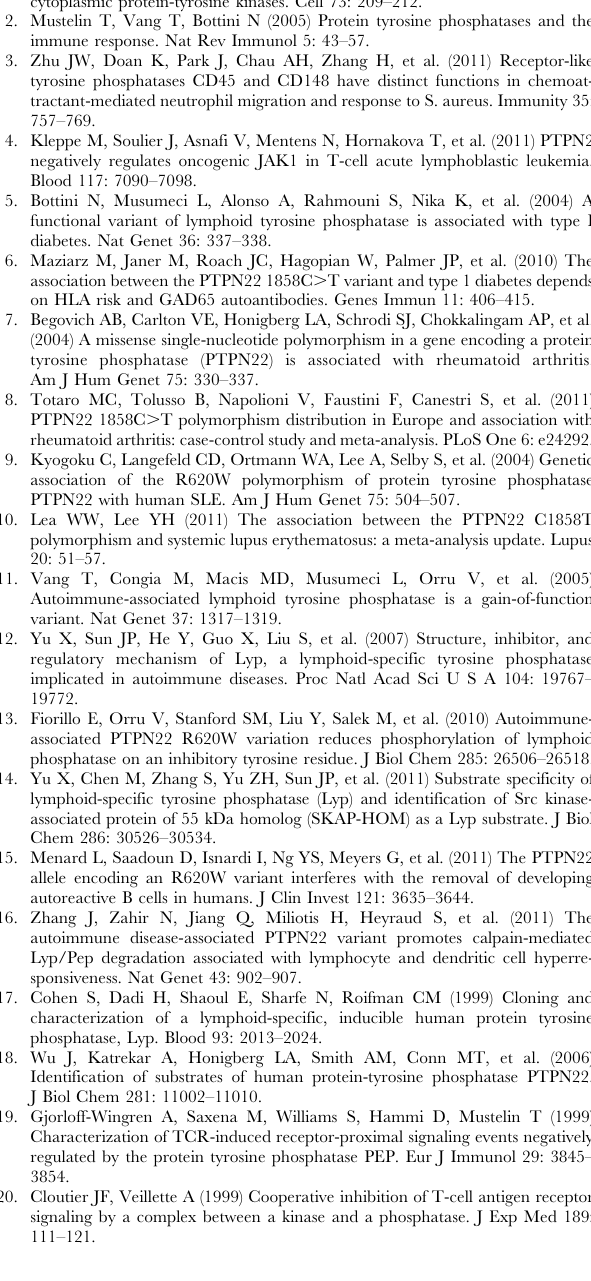
Figure S2 Coomassie blue staining of SDS-polyacryl- amide gel of purified wild-type Lyp catalytic domain and